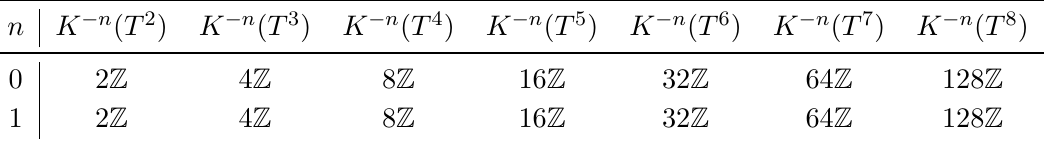
Table 29 . K-groups of tori K n ( T k ) , k = 2 , . . . , 8